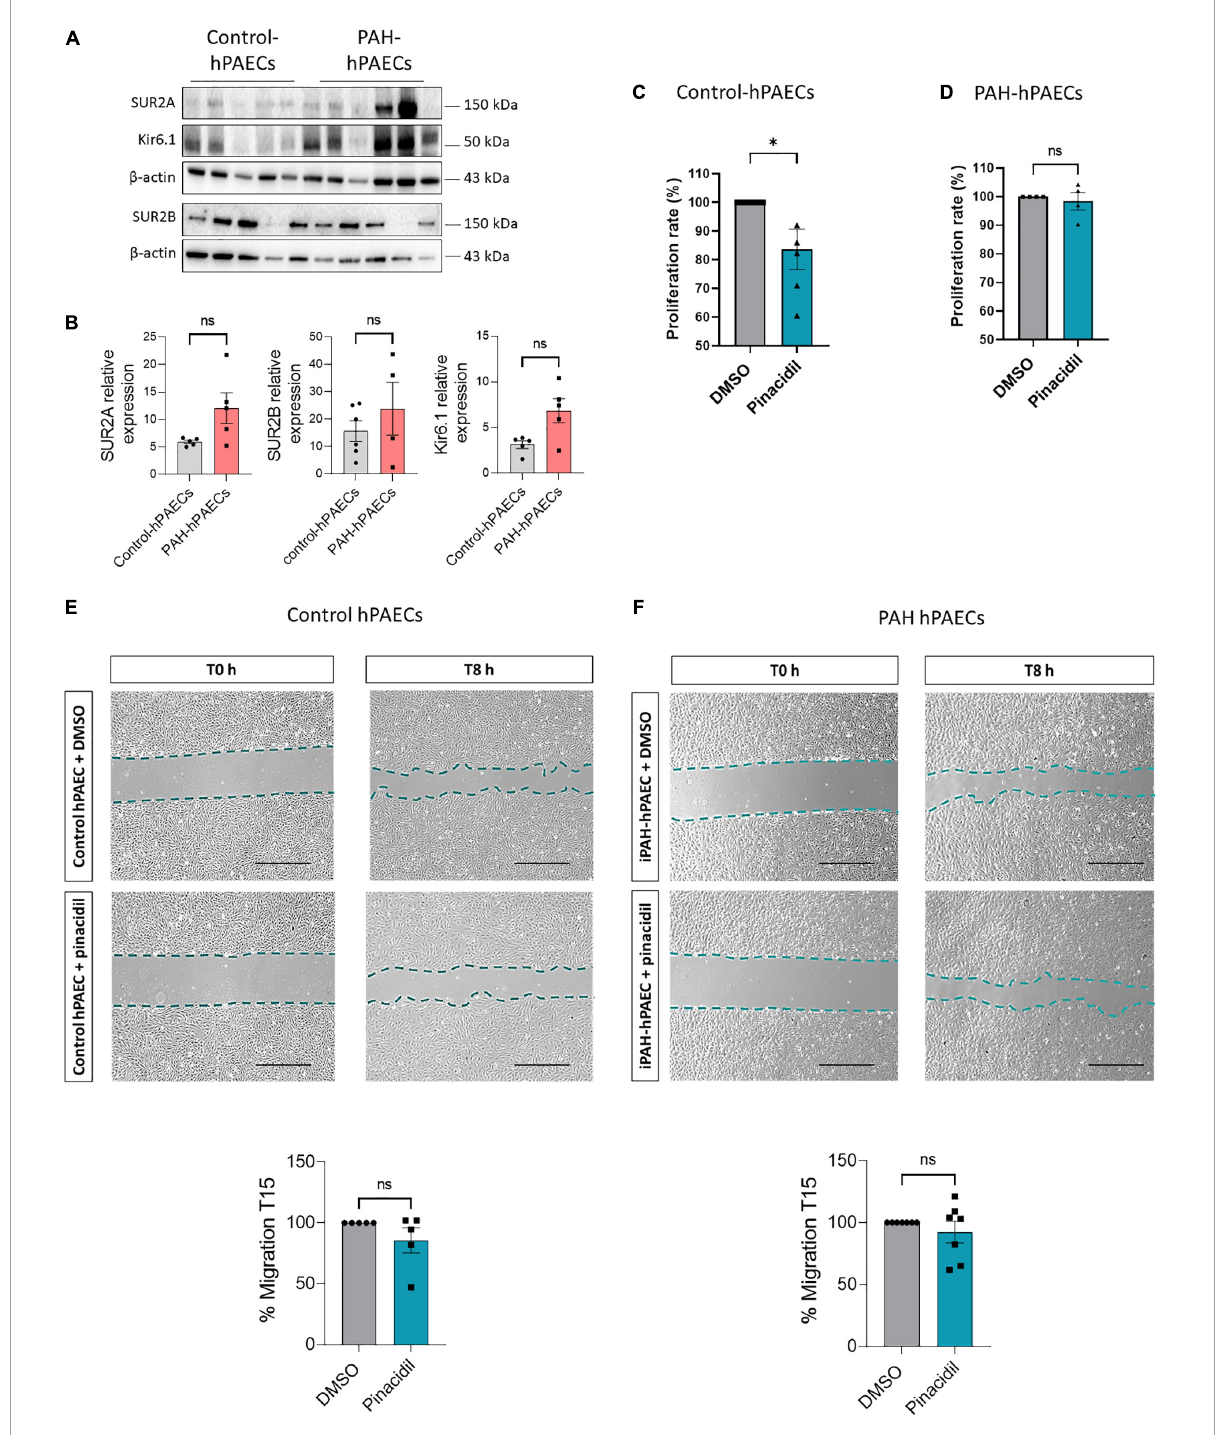
FIGURE2 Pharmacological activation of SUR2/Kir6.1 channel reduced the proliferation in control hPAECs. (A) Representative western blots of SUR2A, SUR2B, and Kir6.1 in hPAECs in the lungs of controls and patients with PAH. (B) Quantification of SUR2A, SUR2B, and Kir6.1 expression in hPAECs from controls and patients with PAH ( n = 4–6). (C,D) Analysis by Bromodeoxyuridine (BrdU) assay of the proliferation rate of hPAECs from controls and patients with PAH treated with pinacidil (10 µ mol/L) or DMSO ( n = 4–5 patients). (E,F) Analysis of the migratory capacity of hPAECs from controls and patients with PAH treated with pinacidil (10 µ mol/L) or DMSO. Scale Bar = 500 µ m ( n = 5–7 patients). ns: non-significant. ∗ p < 0.0 5. Two-tailed unpaired Student t -tests assessed the difference between the two